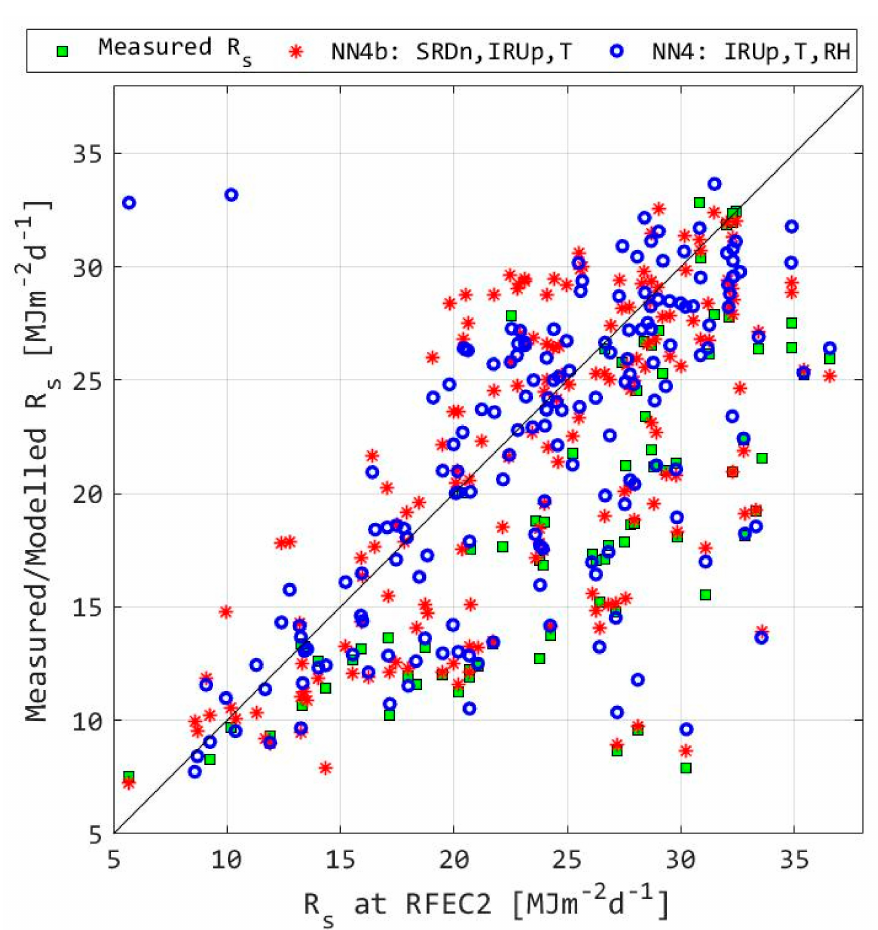
Figure 5. Measured and modelled (NN4 and NN4b) daily irradiance compared to RFEC2